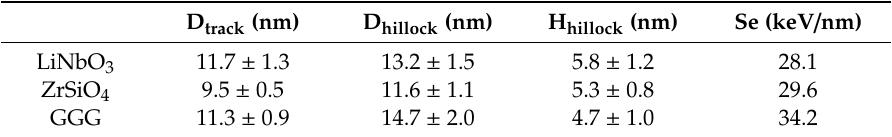
Figure 2. Size distribution of the track diameter, the hillock diameter, and the hillock height in ( a ) LiNbO 3 , ( b ) ZrSiO 4 , and ( c ) Gd 3 Ga 5 O 12 irradiated with 200 MeV Au 32+ at an oblique incidence angle. Table 1. Average diameter of ion tracks (D track ), average diameter of hillocks (D hillock ), average height of hillocks (H hillock ) are listed with standard deviations for LiNbO 3 , ZrSiO 4 , and GGG irradiated with 200 MeV Au 32 + . The corresponding S e values are also listed.